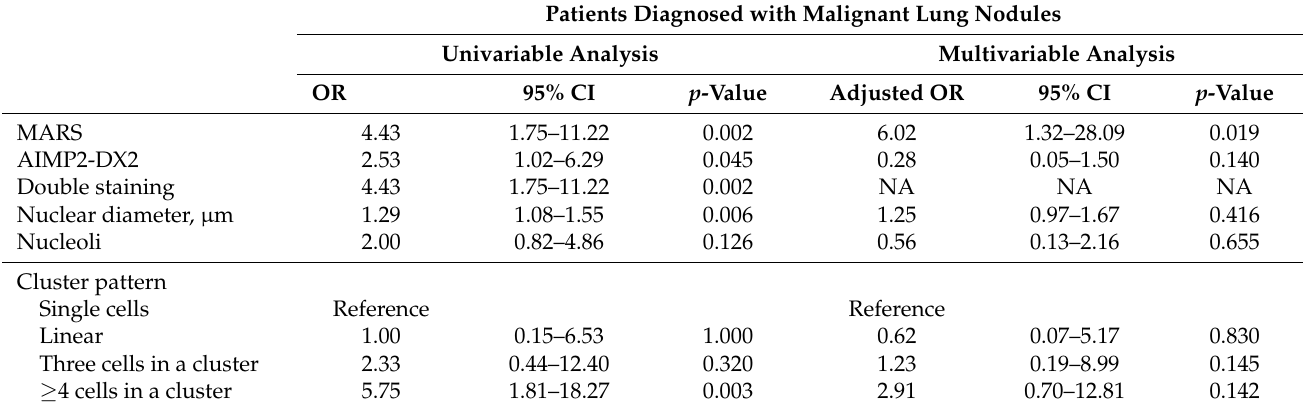
Table 3. Unadjusted and adjusted odds ratios (ORs) for the diagnostic results.